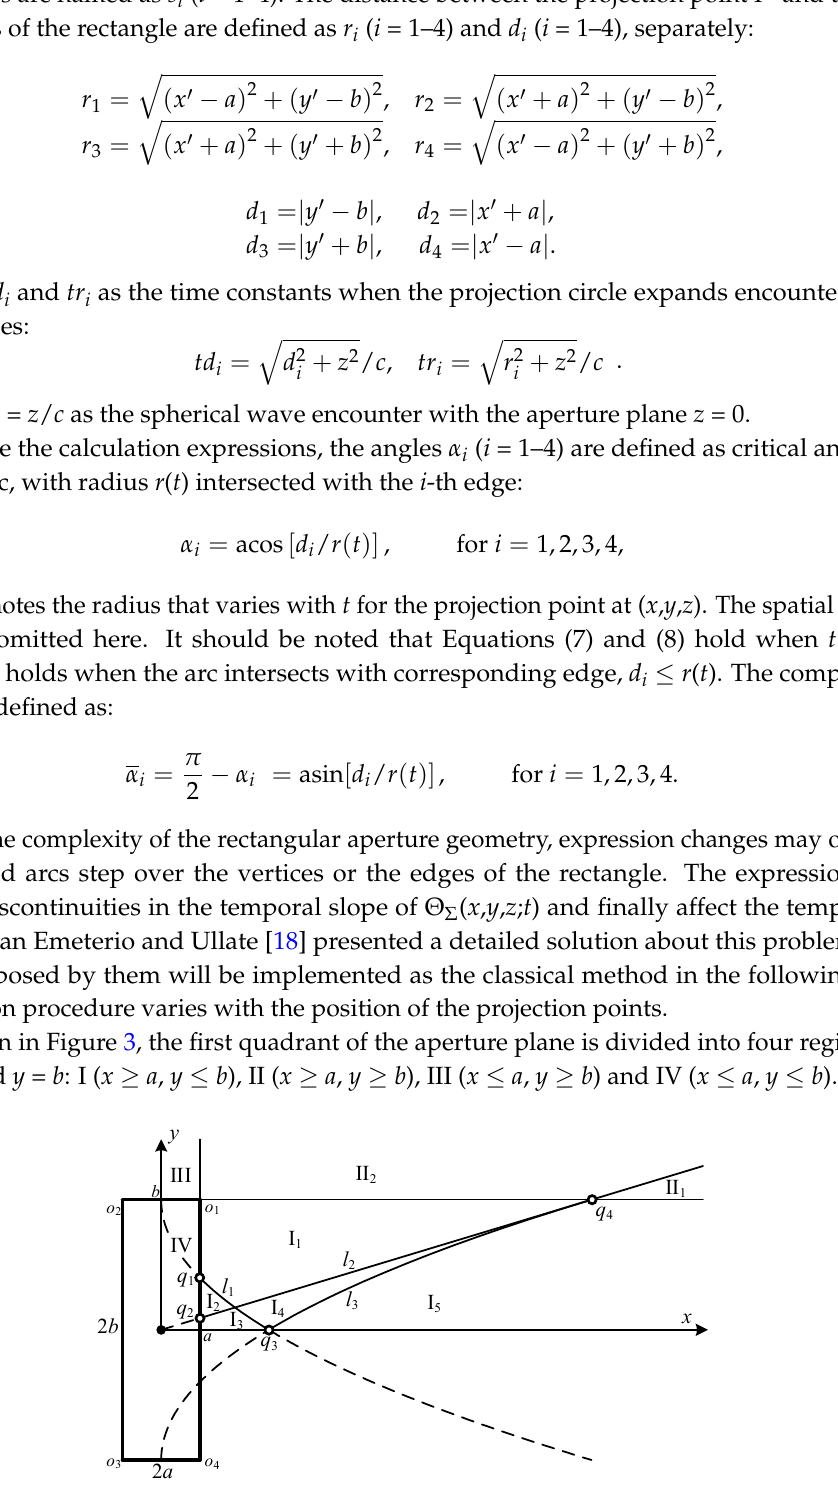
Figure 3. General geometry of the divided regions and sub-regions of the aperture plane. The curves l 1 , l 2 , and l 3 denote r 1 = d 2 , r 2 = r 4 , and r 4 = d 3 separately, which are expressed as: